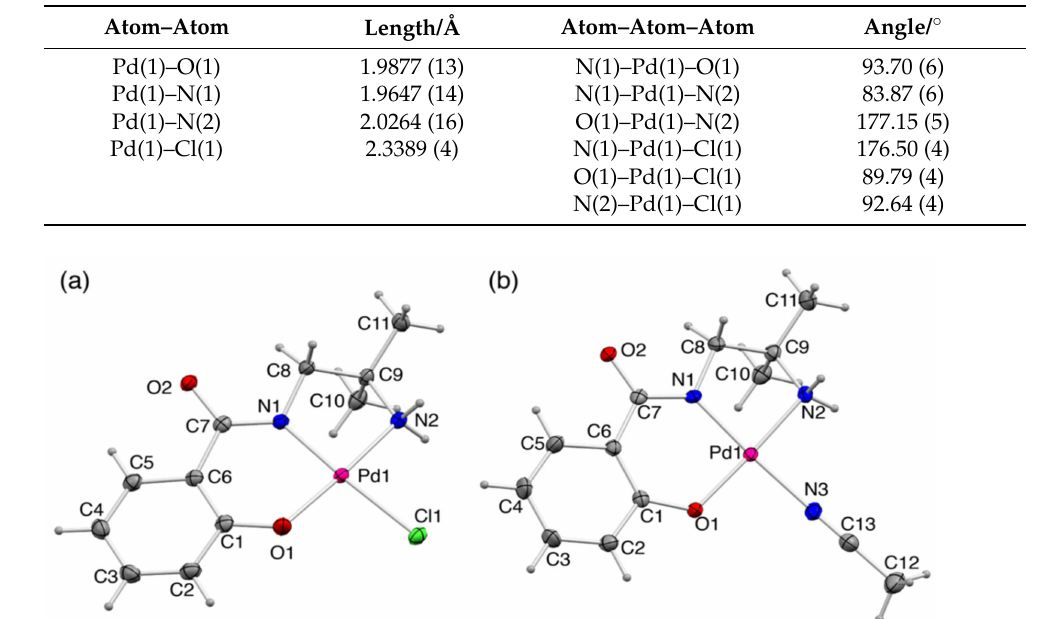
Table 1. Selected bond parameters for 1 .